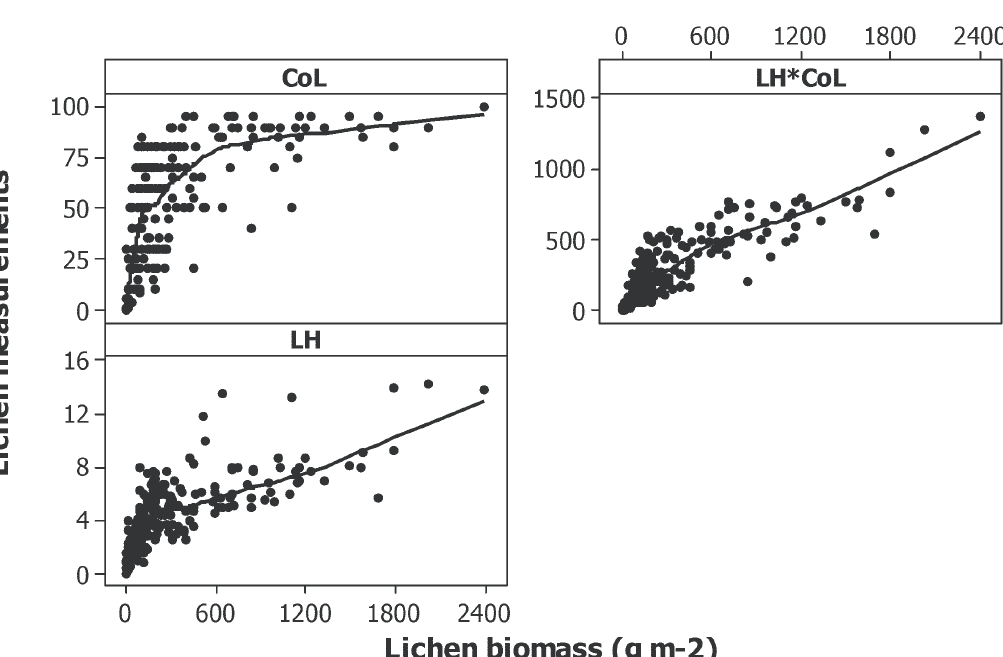
Figure 3. Relationship between measured lichen cover (CoL), lichen height (LH), and lichen volume as estimated by LH × CoL. Lowess smoothers are drawn. Results of the linear regression analyses are shown in the